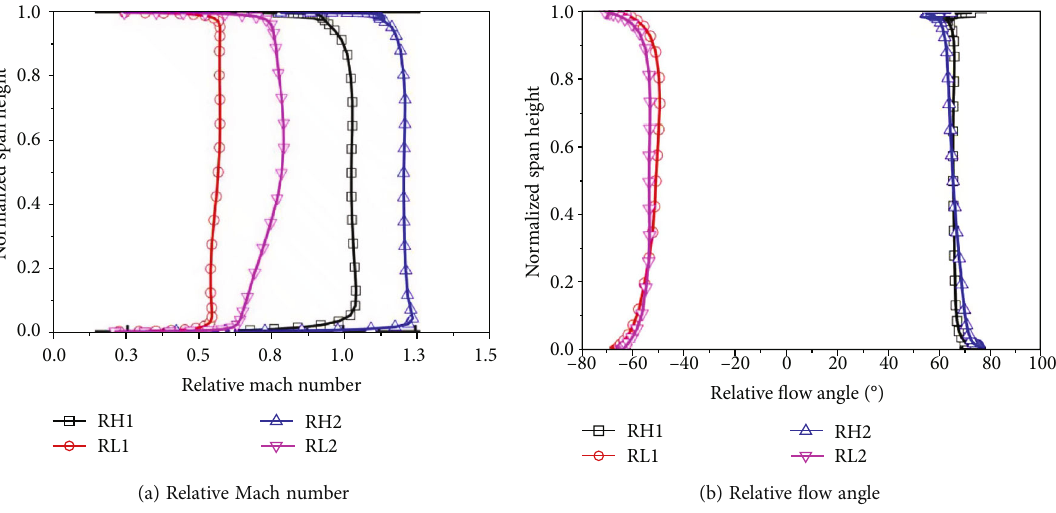
Figure 10: Relative Mach number and fl ow angle distribution along the span.